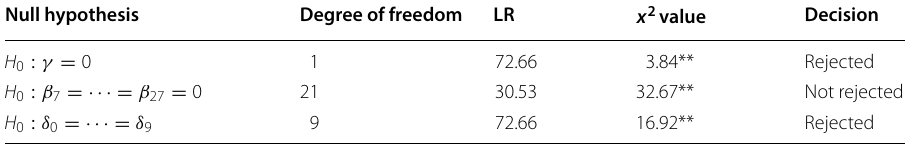
**Statistically significant at 5%